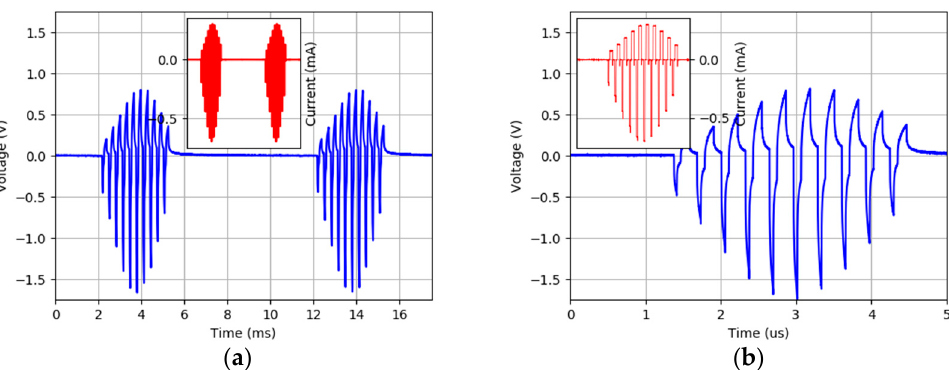
Figure 15. Stimulation waveforms as delivered on electrodes in a saline solution. Currents are recorded during the stimulation with a transimpedance amplifier; voltages are recorded on the electrode All currents are plotted in red in insets; all voltages are plotted in blue. Insets have the same time windows as their parent plot. ( a ) Controllable burst stimulation as performed in [31] consisting in a biphasic waveform ( Tc = 60 µs, Ta = 180 µs) with a gaussian envelope applied on a TIME electrode. ( b ) Temporal zoom on the same stimulus as (i). All electrodes are fully specified in Section 3.1.3.